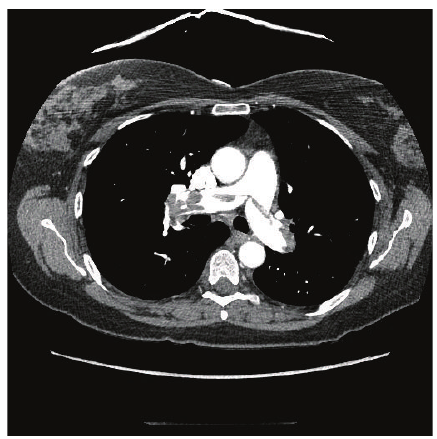
Figure 3: CT angiogram of the chest demonstrating bilateral pulmonary embolus.